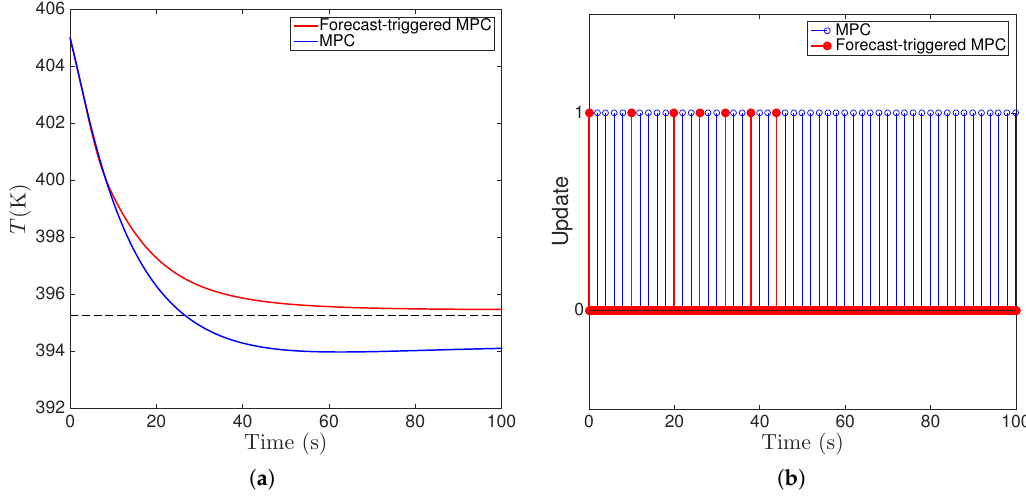
Figure 5. Closed-loop reactor temperature profiles ( a ); and model state update instances ( b ) under the conventional (blue) and forecast-triggered MPC schemes